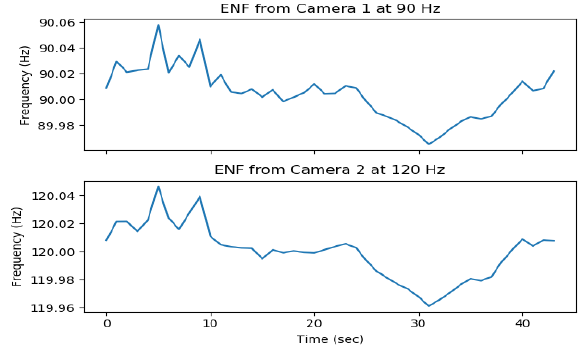
Figure 13. ENF estimated from Multiple cameras at one time instant. Camera 1 had a frame rate of 30 FPS, and camera 2 had a frame rate of 29.98